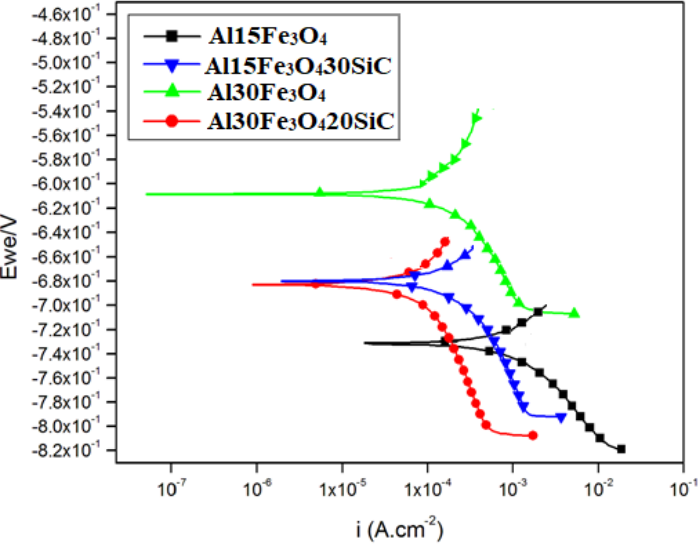
Figure 11. Polarization curves of Al-15Fe 3 O 4 , Al-15Fe 3 O 4 -30SiC, Al-30Fe 3 O 4 , and Al-30 Fe 3 O 4 -20SiC specimen in artificial seawater. Table 2. Corrosion current density ( I corr), corrosion potential ( E corr), polarization resistance ( Rp ), corrosion rate, and effectiveness of corrosion protection ( P.E. ) data.